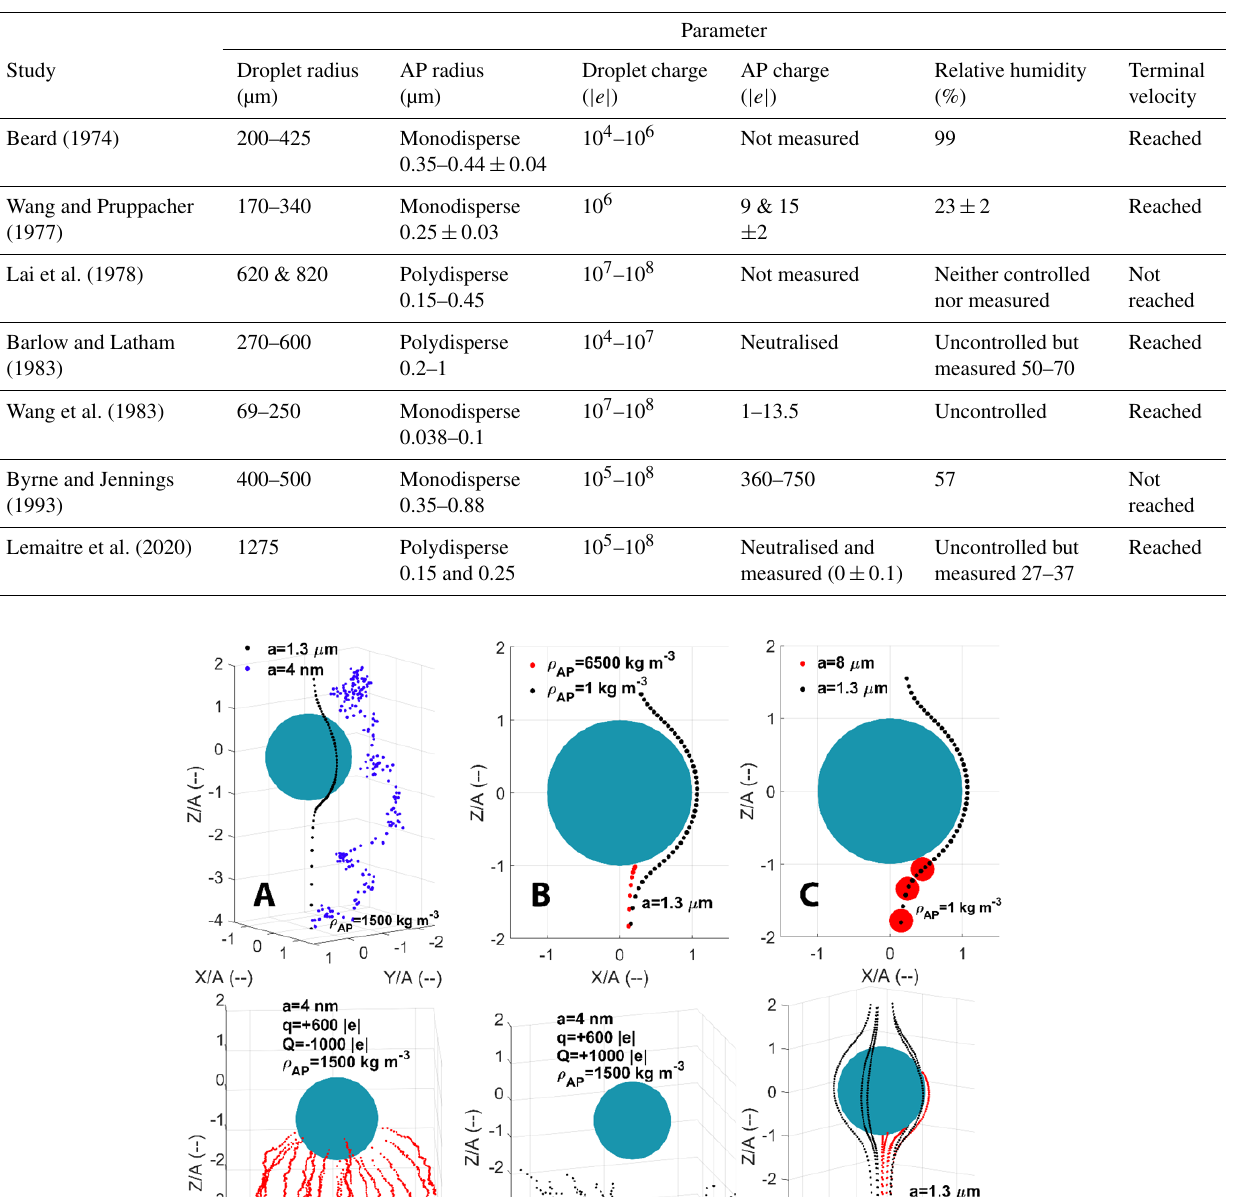
Table 1. Laboratory studies focused on the influence of electric charges on the CE. Charges are presented in number of elementary charges.